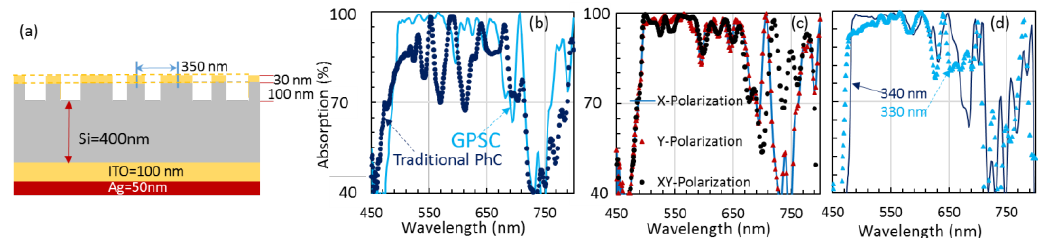
Figure 2. ( a ) Schematic of a silicon device patterned with a GPSC with a unit cell of 6a × 6a (a = 350 nm). The dashed yellow indicates the top PEDOT:PSS film for a device application. ( b ) Absorption spectra for light (x-polarization) incident at 0 ◦ onto the silicon device patterned with GPSC, and with a traditional photonic crystal in regular square lattice. ( c ) Absorption spectrum for light incident at 0 degree into the device in ( a ) for light with x, y and x-y polarizations. ( d ) Absorption spectrum for x-polarized light incident at 0 ◦ into the GPSC silicon same as the one in ( a ) but a = 340 and 330 nm.